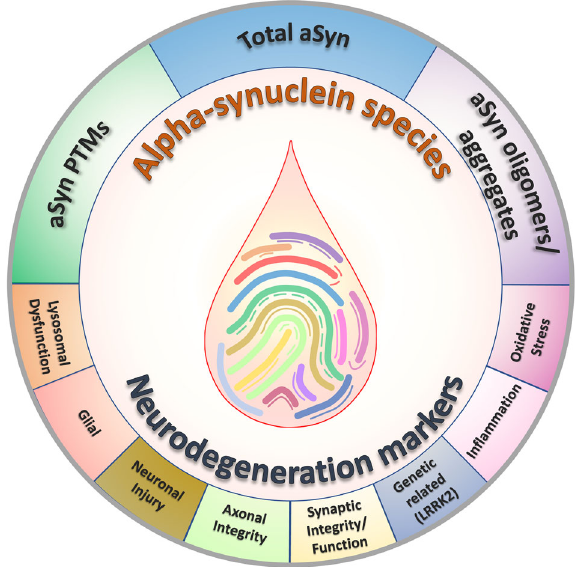
Fig. 10 Schematic illustration of biomarker fi ngerprinting: a multimarker approach including the diversity of aSyn species with other neurodegenerative biomarkers. Partially created with